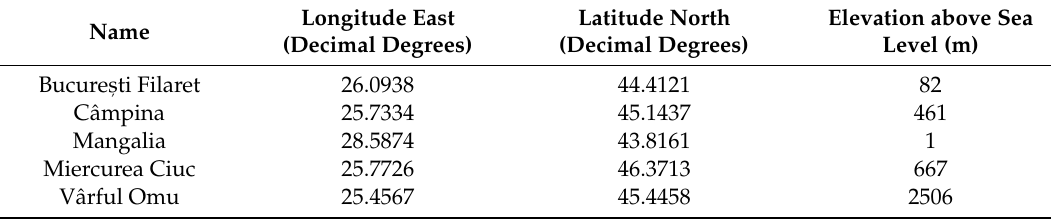
Table 3. Metadata of the weather stations from which the air temperature data was